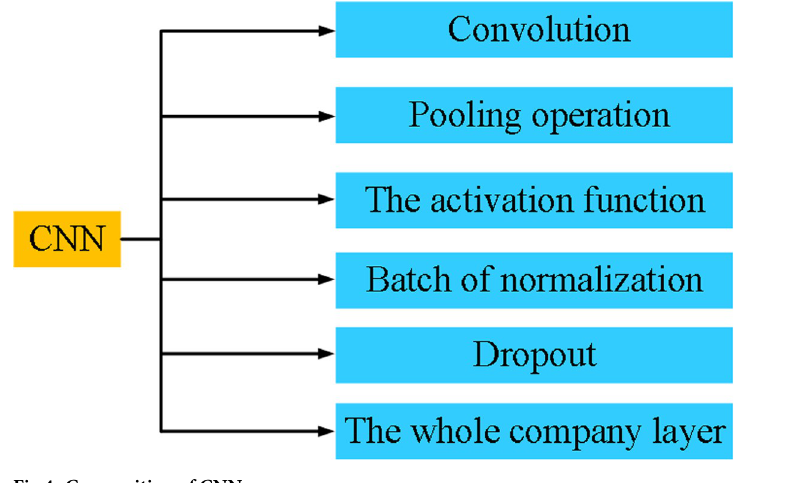
Fig 4. Composition of